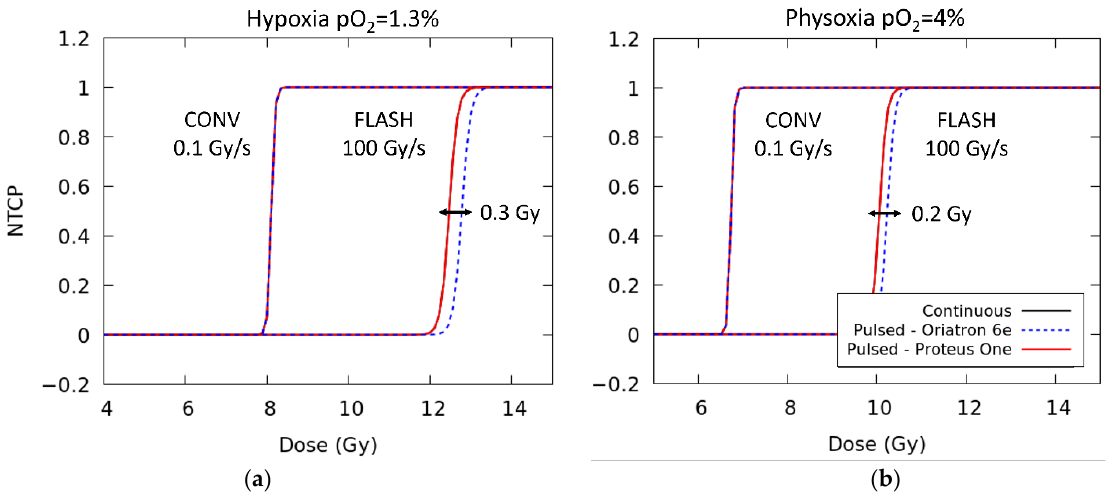
Figure 7. Dose-response curves at either conventional dose rate (0.1 Gy/s) or FLASH dose rates (100 Gy/s) for two different levels of oxygenation: ( a ) 1.3% oxygen and ( b ) 4% oxygen. For each dose rate, the results are displayed considering the temporal microstructure of two clinical accelerators (Proteus One [44] and Oriatron 6e [45]) and a continuous beam